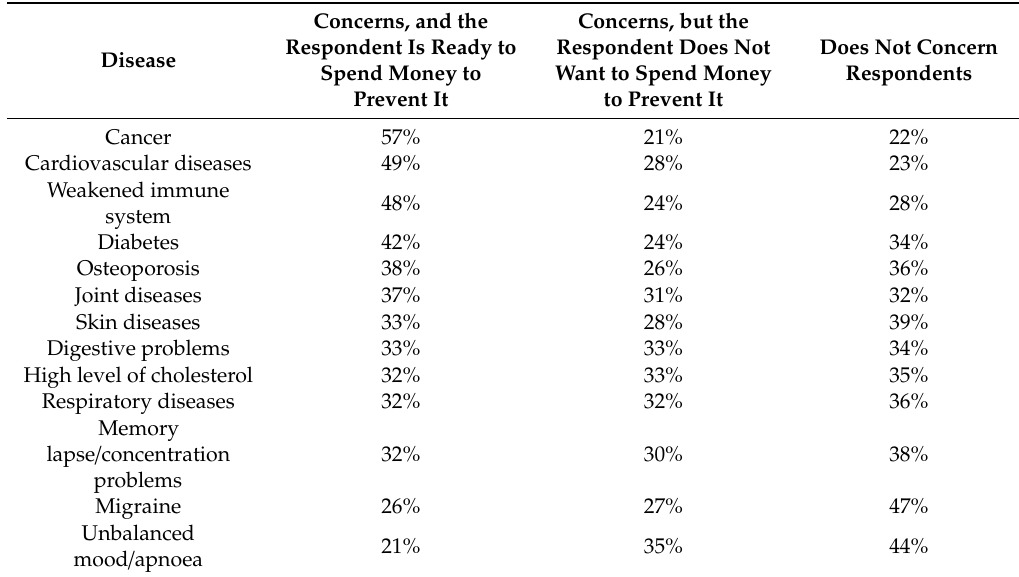
Table 2. The attitude of respondents towards di ff erent health problems and their propensity to spend money to decrease the probability of their